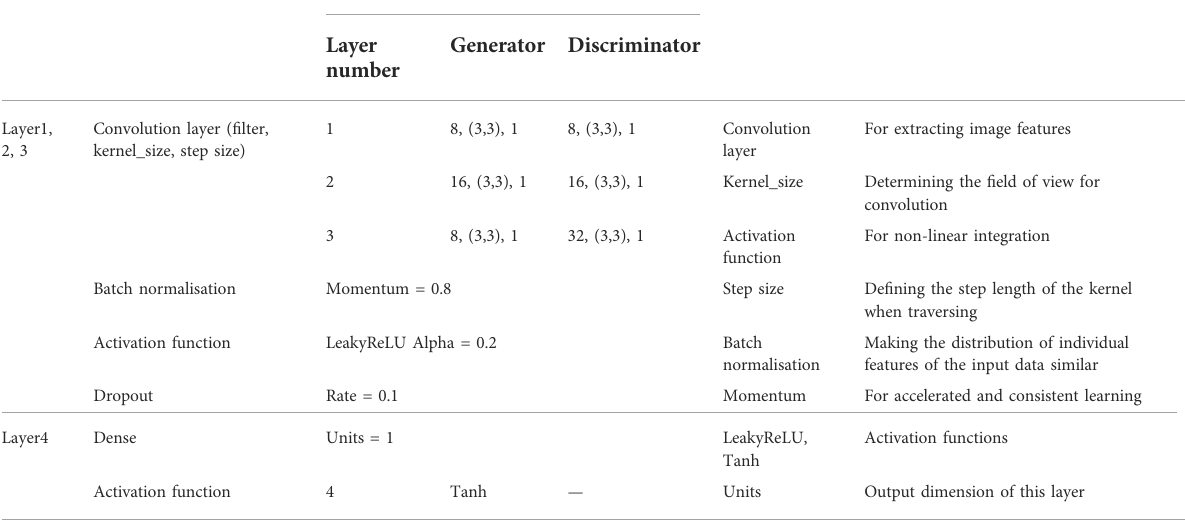
TABLE 1 Structural parameters of D and G.